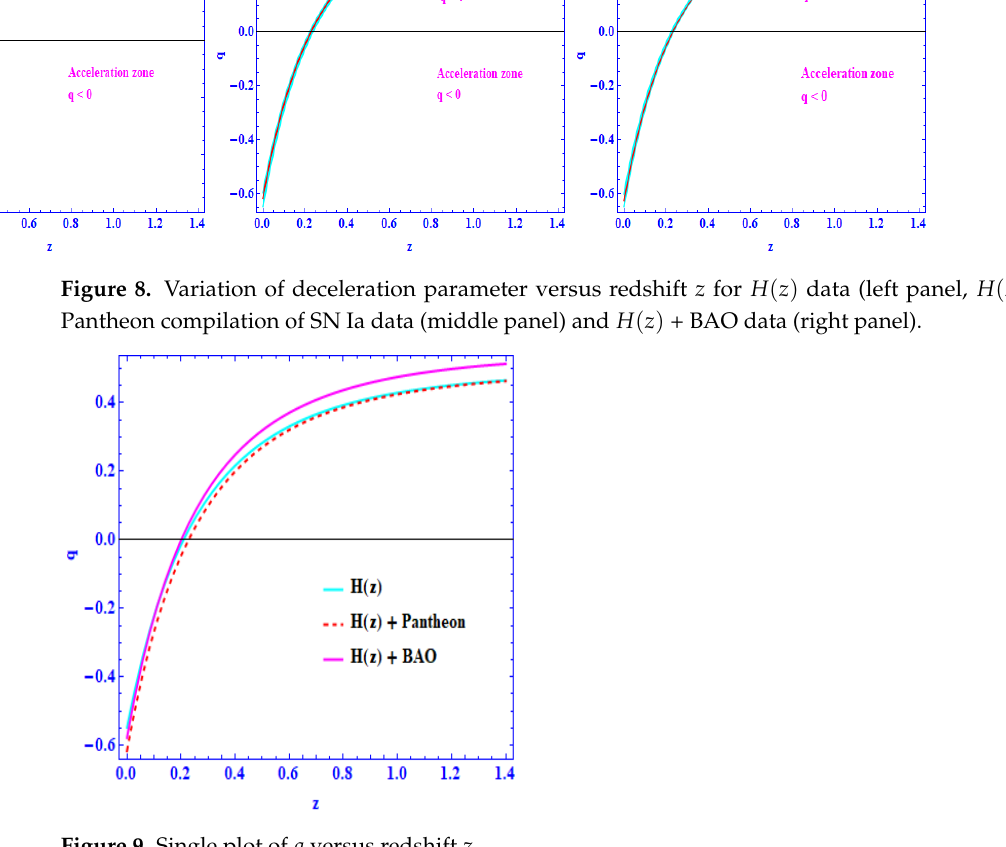
Figure 9. Single plot of q versus redshift z